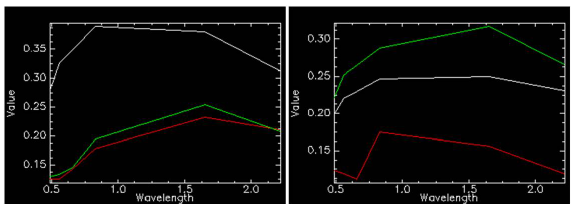
Figure 2. Spectral libraries used to make Linear Spectral